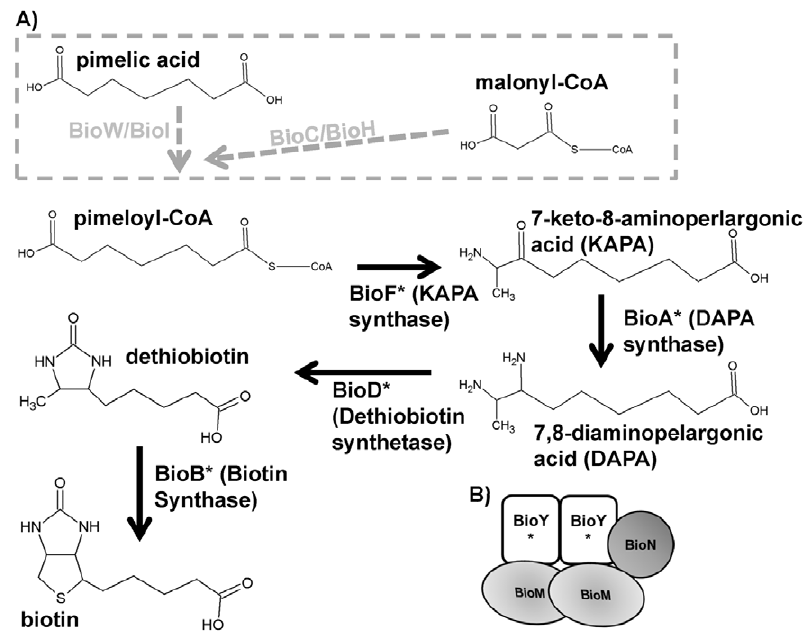
Figure 1. Biotin synthesis and transport in bacteria. The characterized biotin synthesis pathways (A) and the ECF biotin transport mechanism (B) are depicted. Alternative ECF subunit configurations are not shown. Asterisks indicate the presence of a chlamydial homolog based upon genome annotations. The grey dashed box indicates alternative pathways used to synthesize pimeloyl-CoA. Chemical structures were drawn using ChemSketch from ACDLabs.